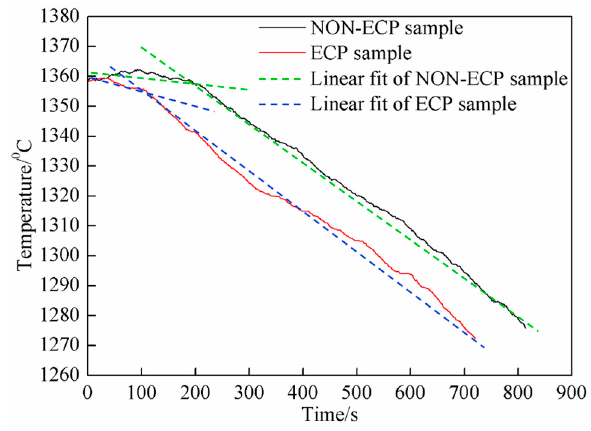
Figure 5. The cooling curve of HHCCI during solidification.